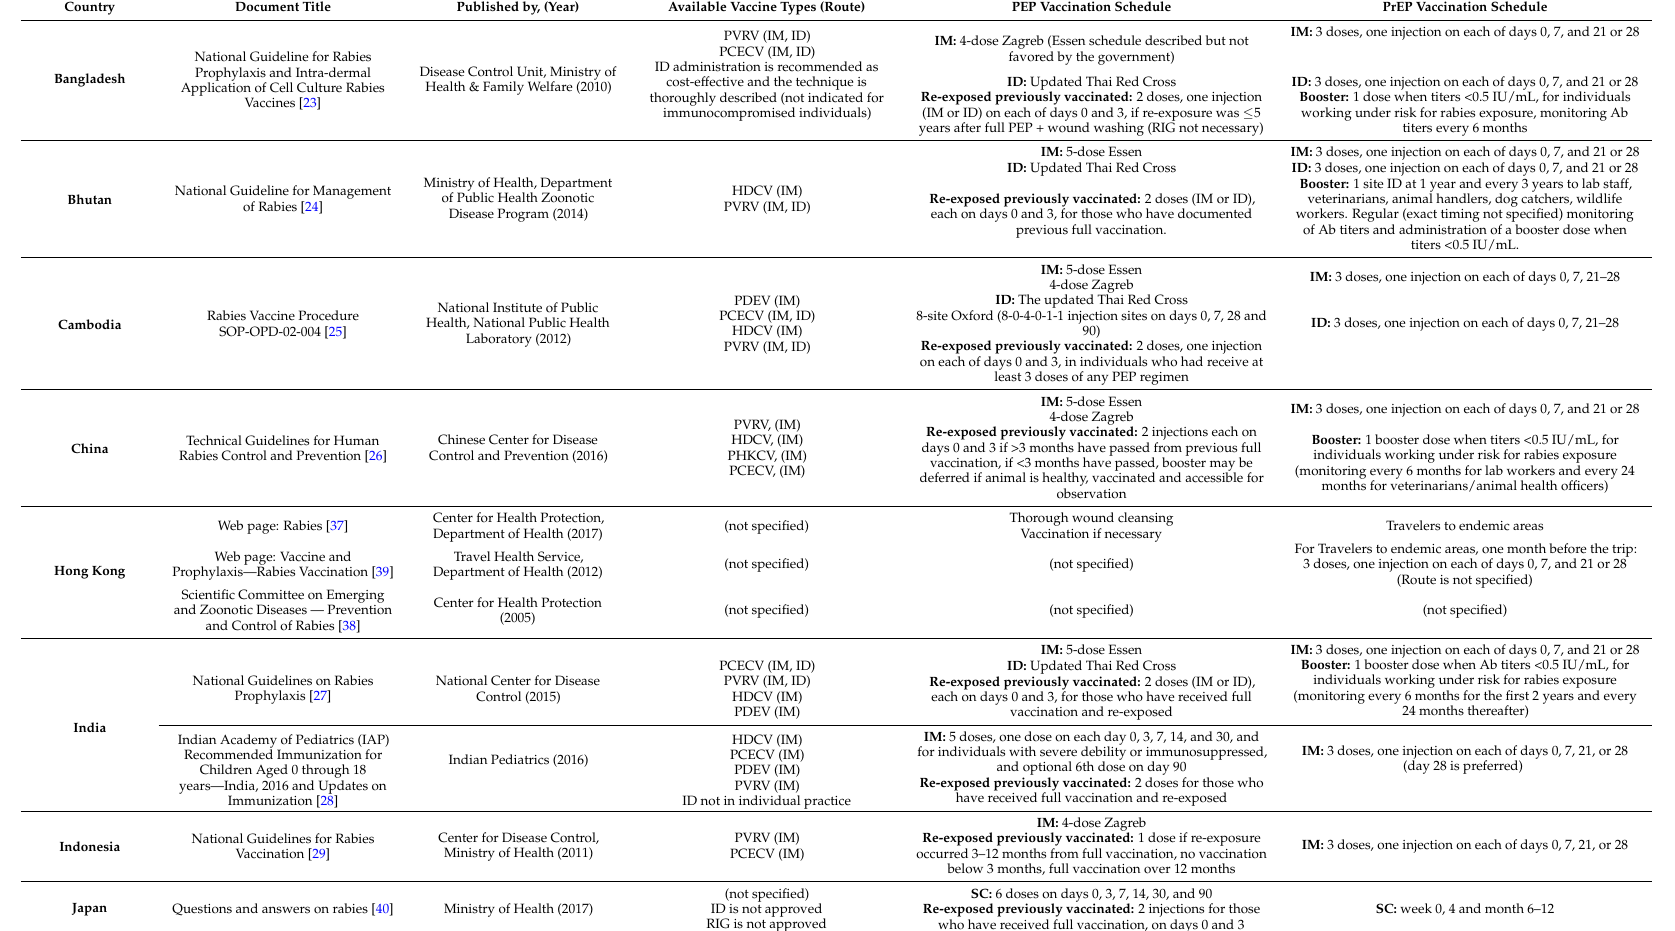
Table 2. Summary of available information on vaccination schedules, within the retrieved documents, by country. Country AvailableVaccineTypes(Route) PEPVaccinationSchedule